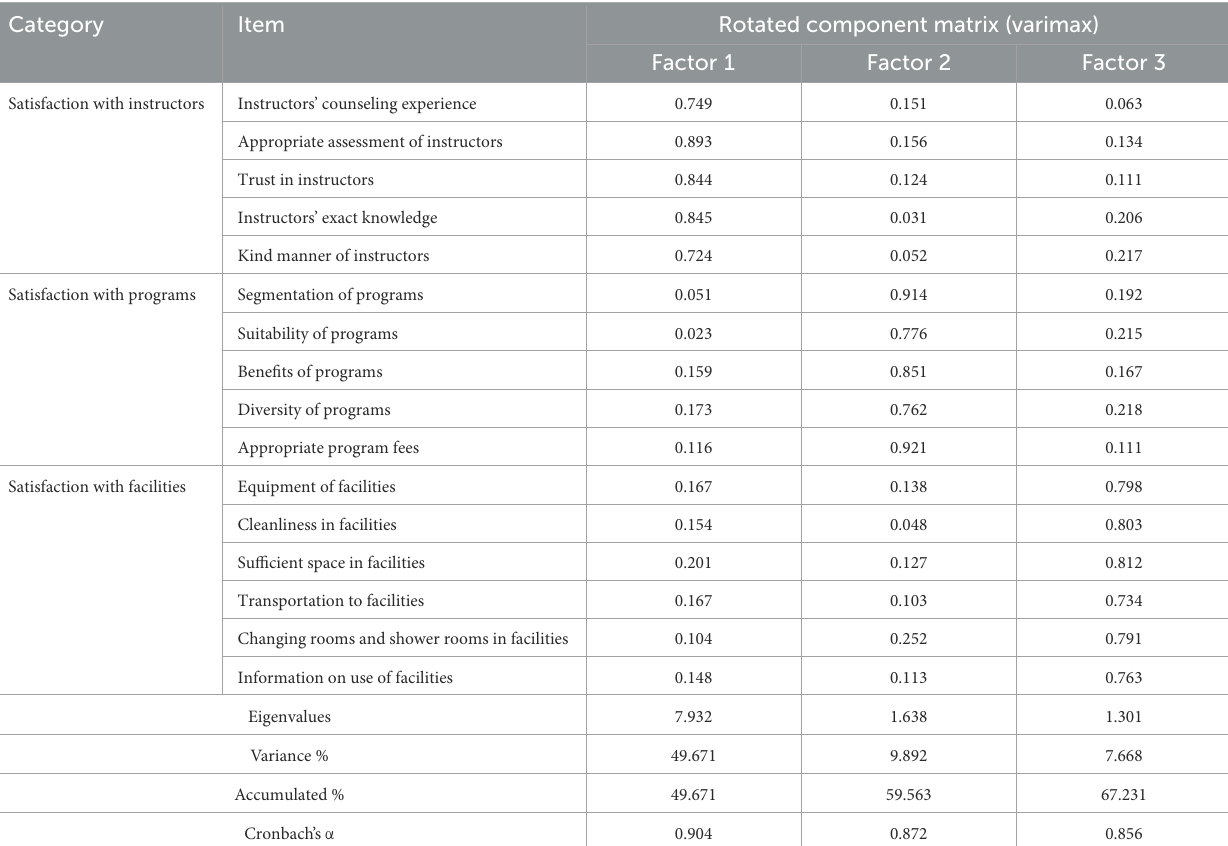
TABLE 2 Results of the validity and reliability